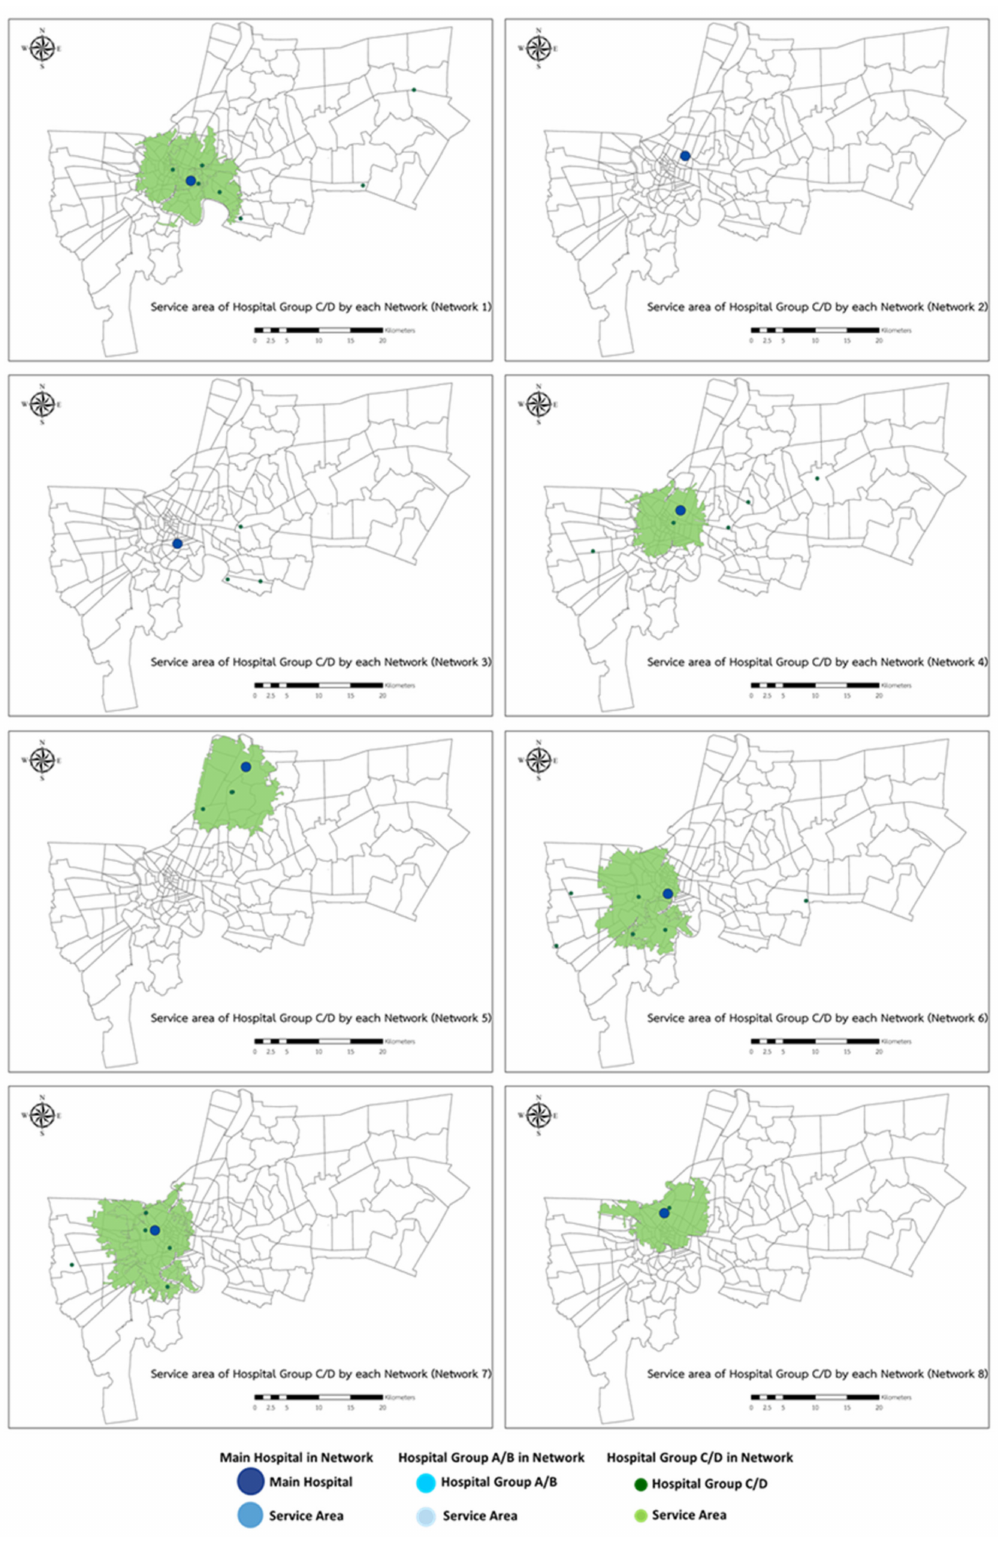
Figure 13. Service areas of Group C/D hospitals by